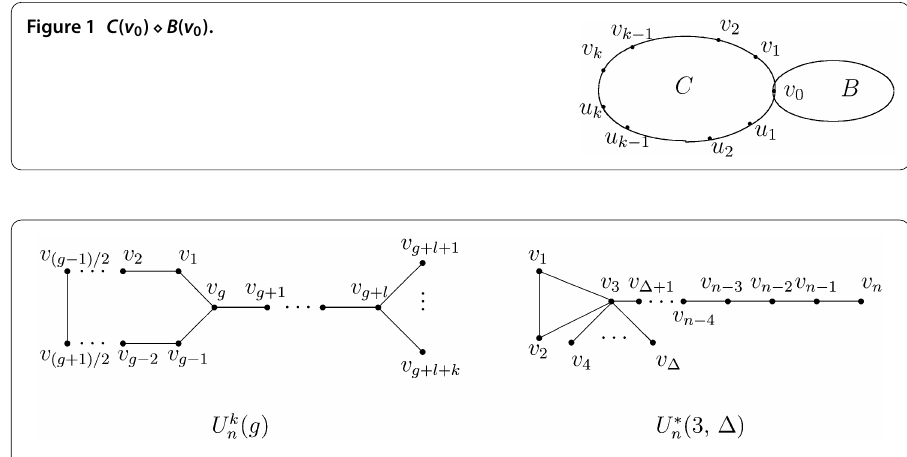
Figure 2 U k n ( g ) and U ∗ n (3, (cid:2)